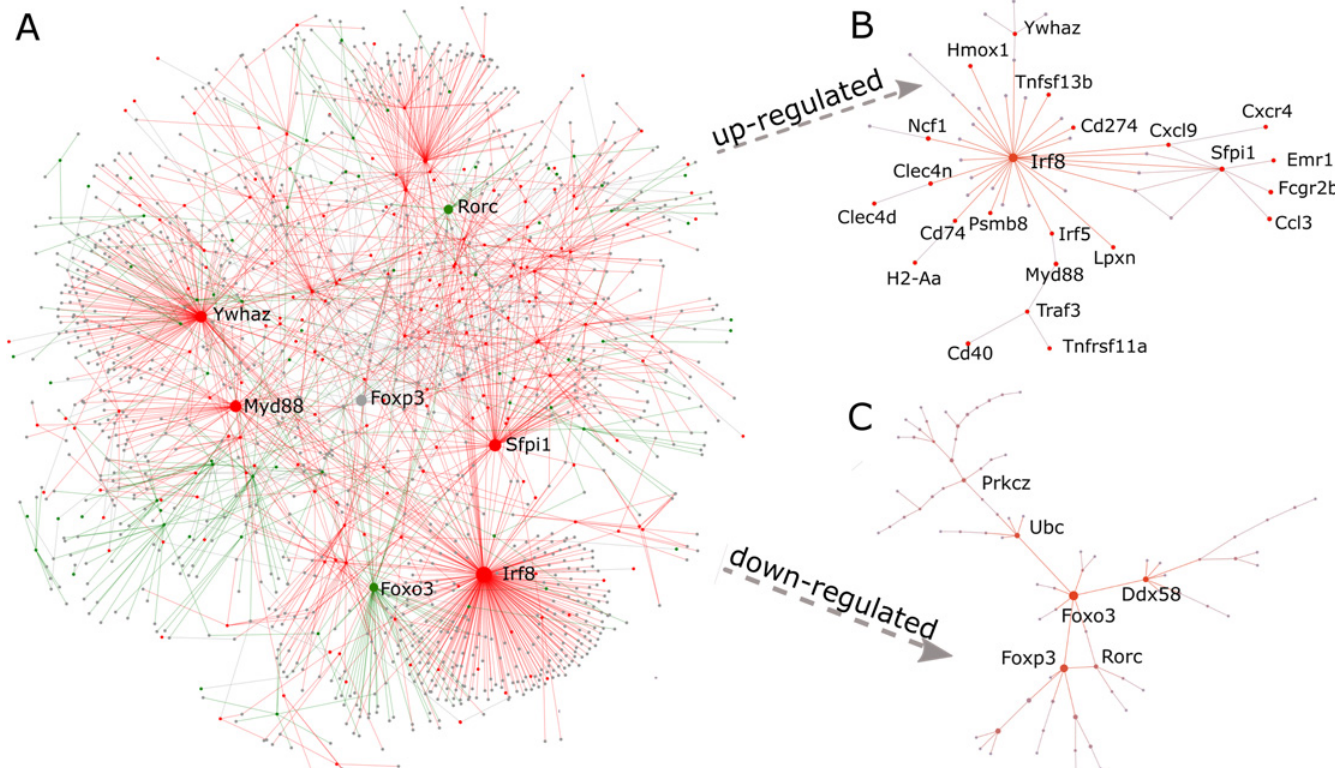
Fig 5. PPI subnetwork analysis of DE genes. (A) The subnetwork using all DE genes. Nodes in red indicate upregulated genes, nodes in green indicate down-regulated genes, and nodes in grey are interaction partners of the DE genes; (B) The PPI subnetwork for up-regulated genes; (C) The PPI subnetwork for down-regulated